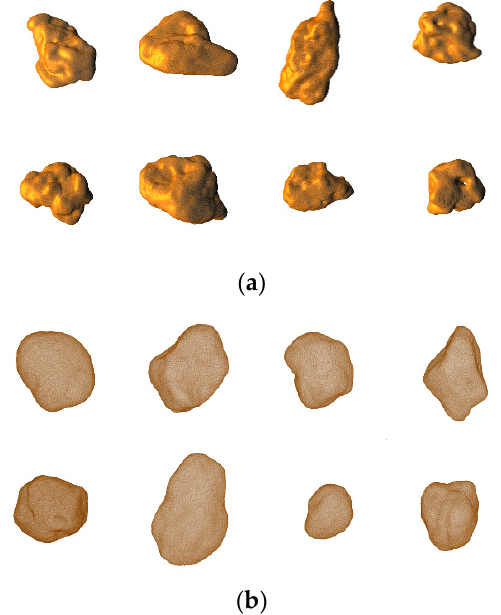
Figure 2. CT scan images of the tested calcareous sand and quartz sand particles: ( a ) calcareous sand particles; ( b ) quartz sand particles.